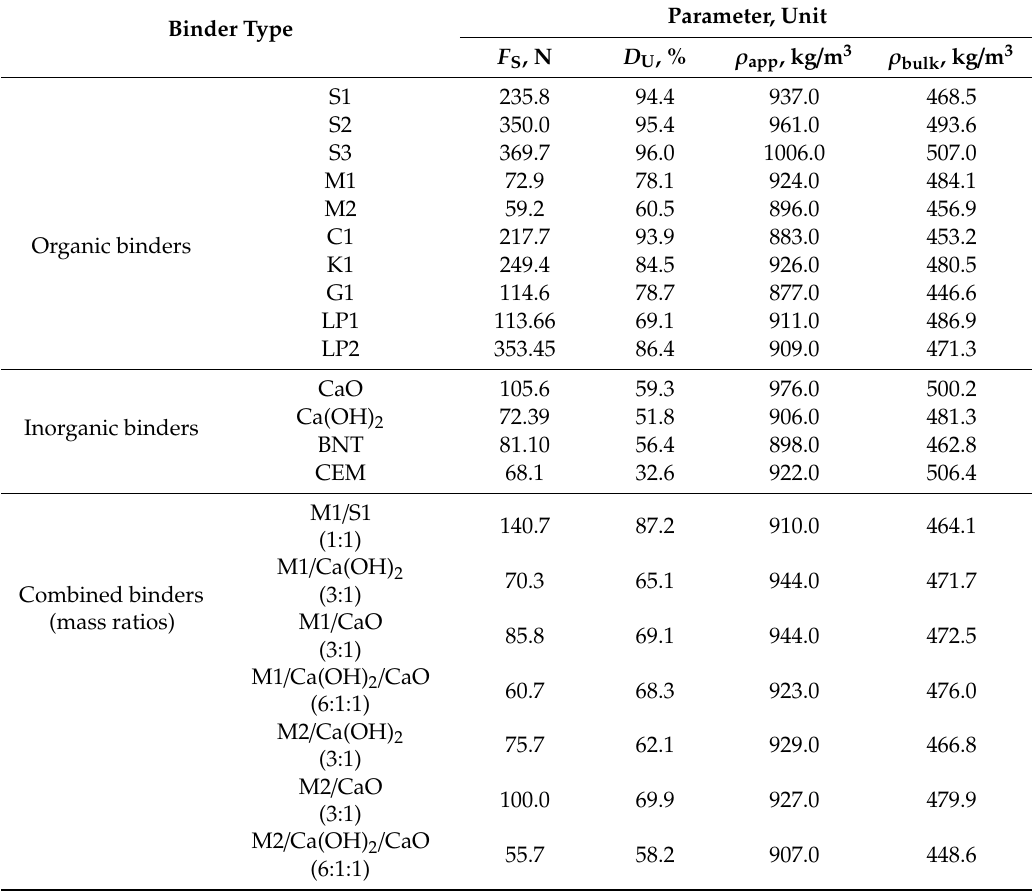
Table 6. Properties of briquettes produced (variable: Binder